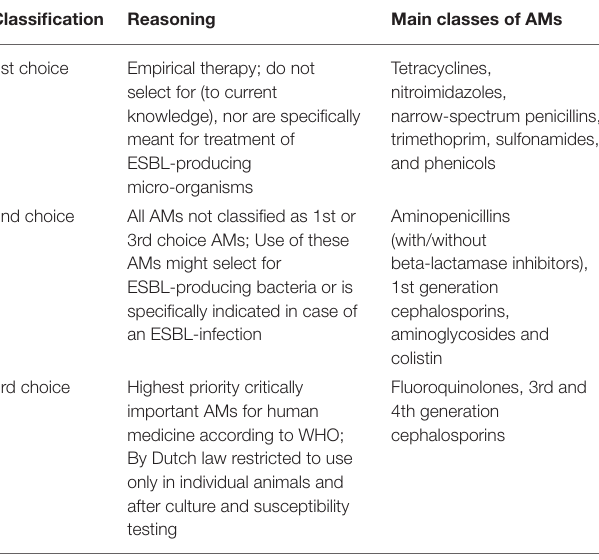
TABLE 1 | Classification of veterinary antimicrobials (AMs) in 1st, 2nd, and 3rd choice AMs, according to Dutch policy on veterinary AMU. Classification